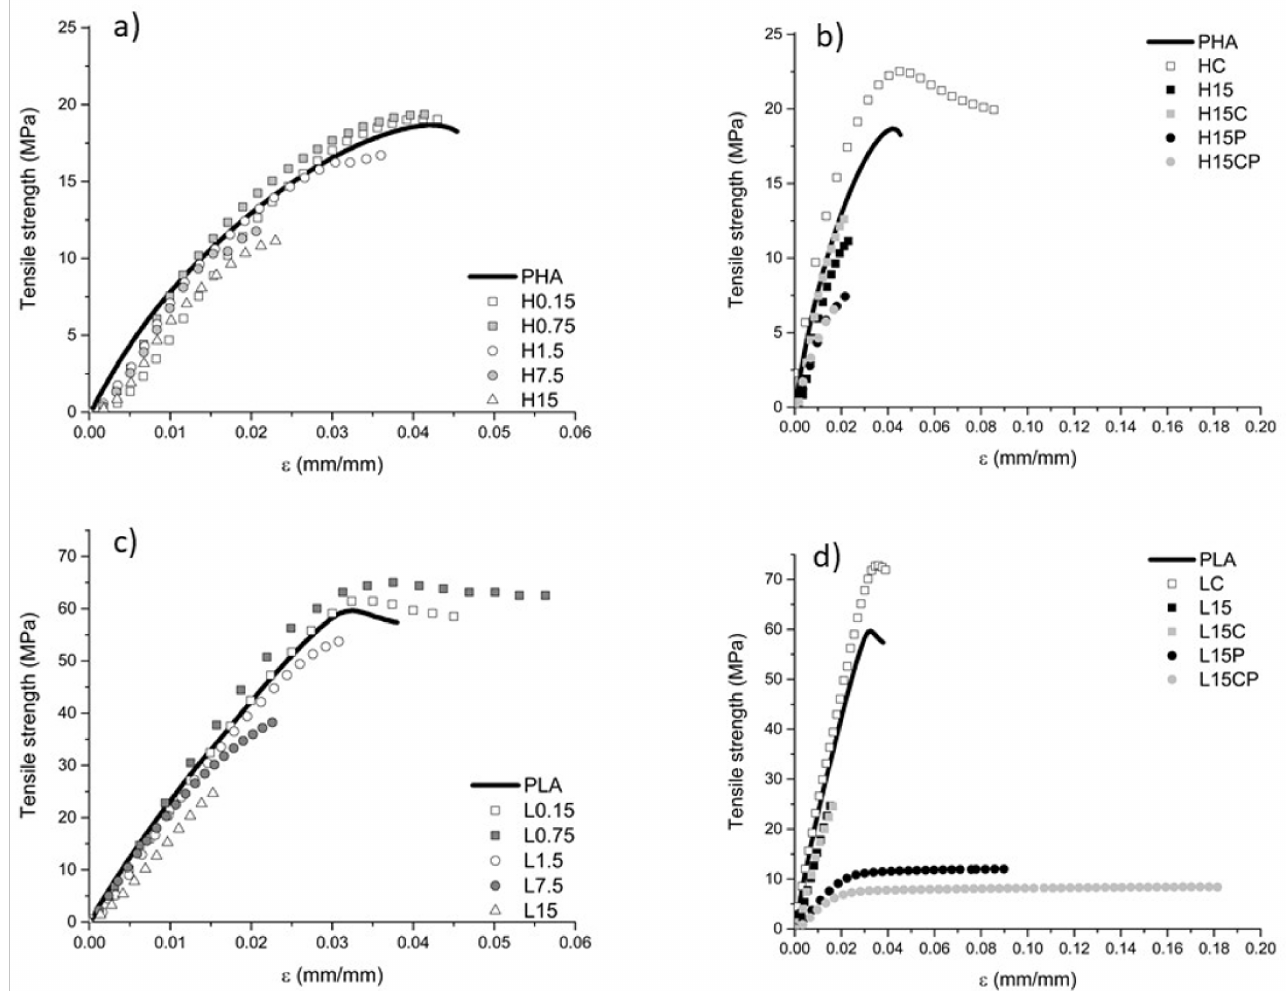
Figure 6. Tensile–strain curves of the films with different GNPs concentrations, from 0.15 to 15 wt.% ( a , c ) display tensile curves of PHA and PLA, respectively, with different GNP content (from 0.15 to 15 wt.%). ( b , d ) are PHA and PLA samples reinforced with 15 wt.% GNP and the different additions here explored, CNC and